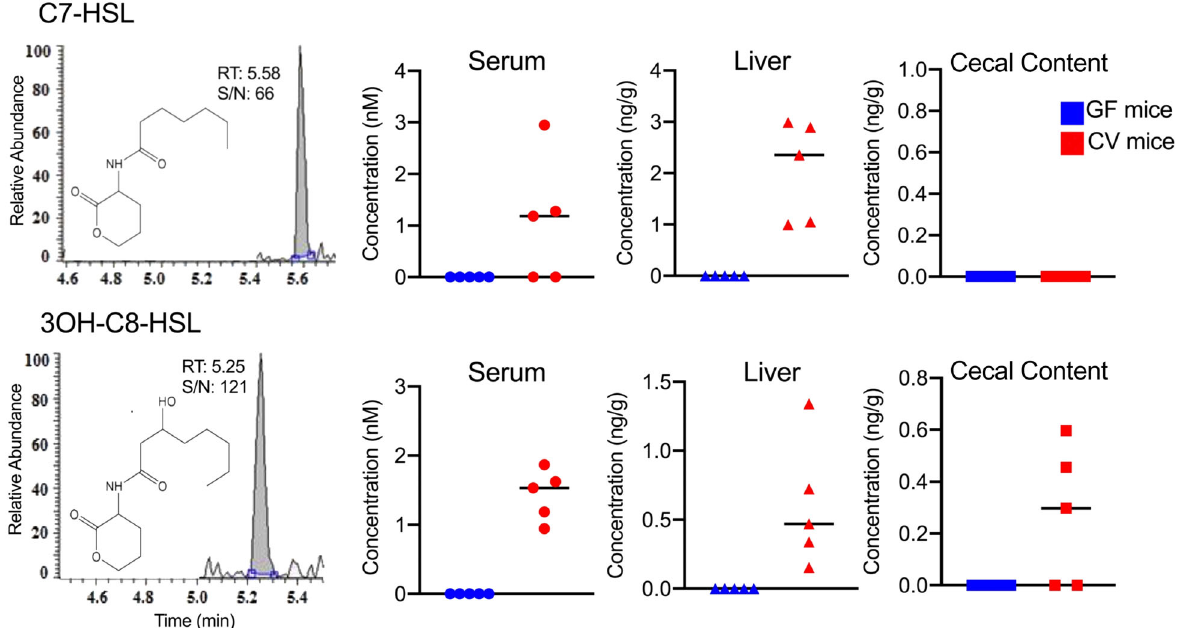
Fig. 2 Typical UPLC-ESI-MS/MS chromatograms of short side-chain AHLs (C7-HSL and 3OH-C8-HSL) detected in biological samples and the corresponding concentrations in the biological samples (cecal contents, sera, and livers) of conventional (CV) and germ-free (GF) mice. RT retention time, S/N signal-to-noise